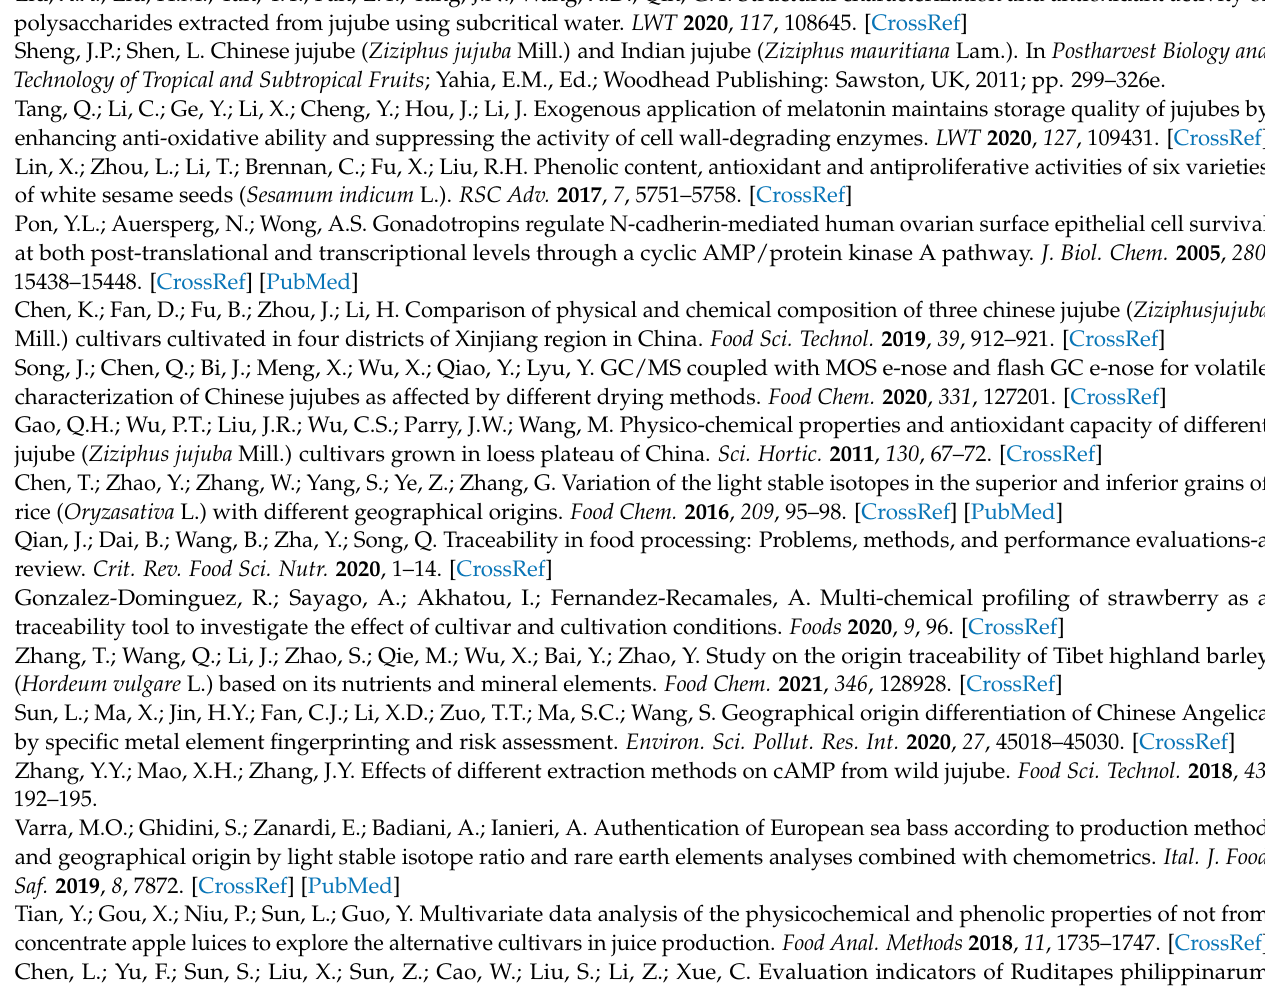
Table S1: Reference conditions of sample digester; Table S2: Contents of 15 individual amino acids in Chinese jujubes from different categories; Table S3: Characteristics of 31 quality indicators of Chinese jujubes; Table S4: The scores and ranking of Chinese jujubes of different